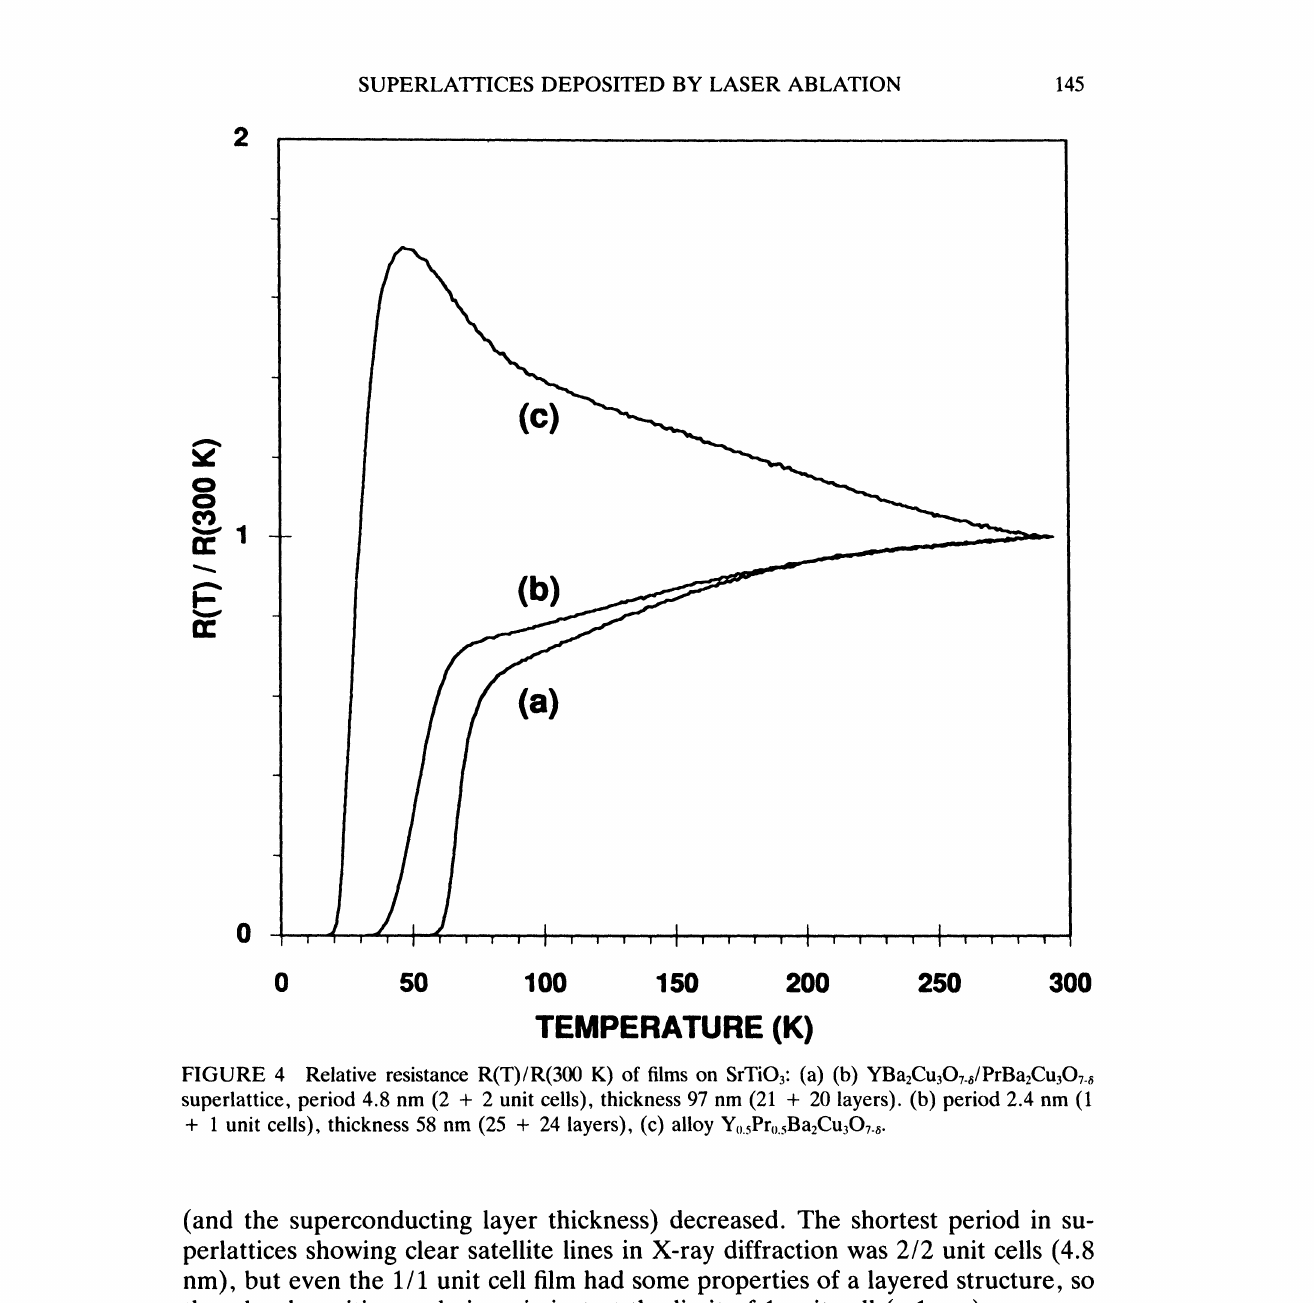
FIGURE 4 Relative resistance R(T)/R(300 K) of films on SrTiO3: (a) (b) YBa2Cu3OT./PrBa2Cu3OT. superlattice, period 4.8 nm (2 + 2 unit cells), thickness 97 nm (21 + 20 layers). (b) period 2.4 nm (1 + unit cells), thickness 58 nm (25 + 24 layers), (c) alloy